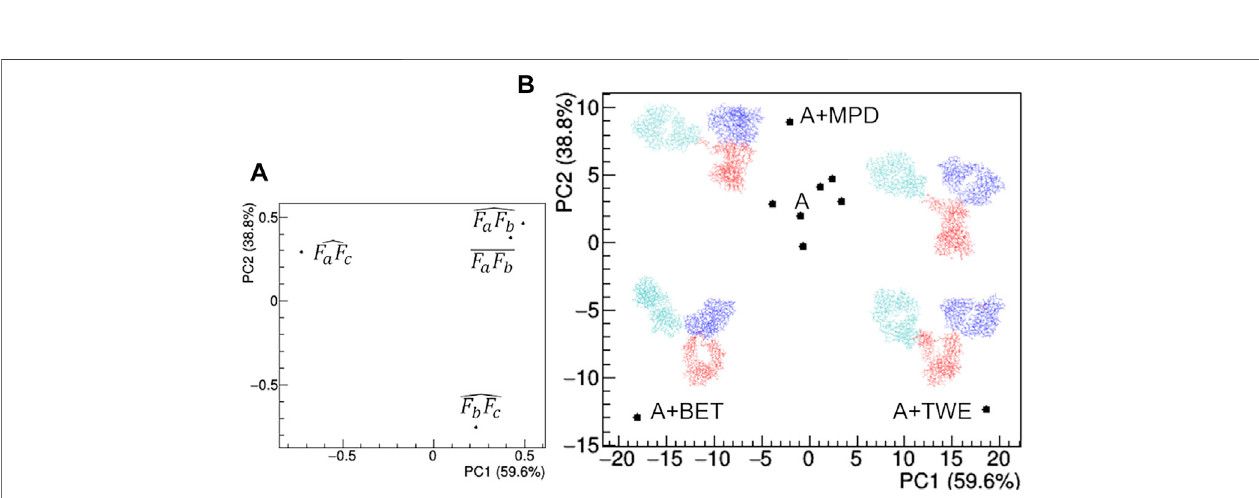
FIGURE 12 | Comparison based on PCA of geometrical features of rituximab models obtained from SAXS measurements in the presence of several additives. (A) PCA loadings values showing the role of individual geometrical parameters in discriminating the models; (B) PCA scores values showing the model discrimination. The models are drawn next to their representative points, with Fa, Fb and Fc coloured in cyan, blue and red, respectively. The fraction of the total data variance explained by the fi rst (PC1) and second (PC2) principal component is reported on relative the axes of the loadings (A) and scores (B) plots.